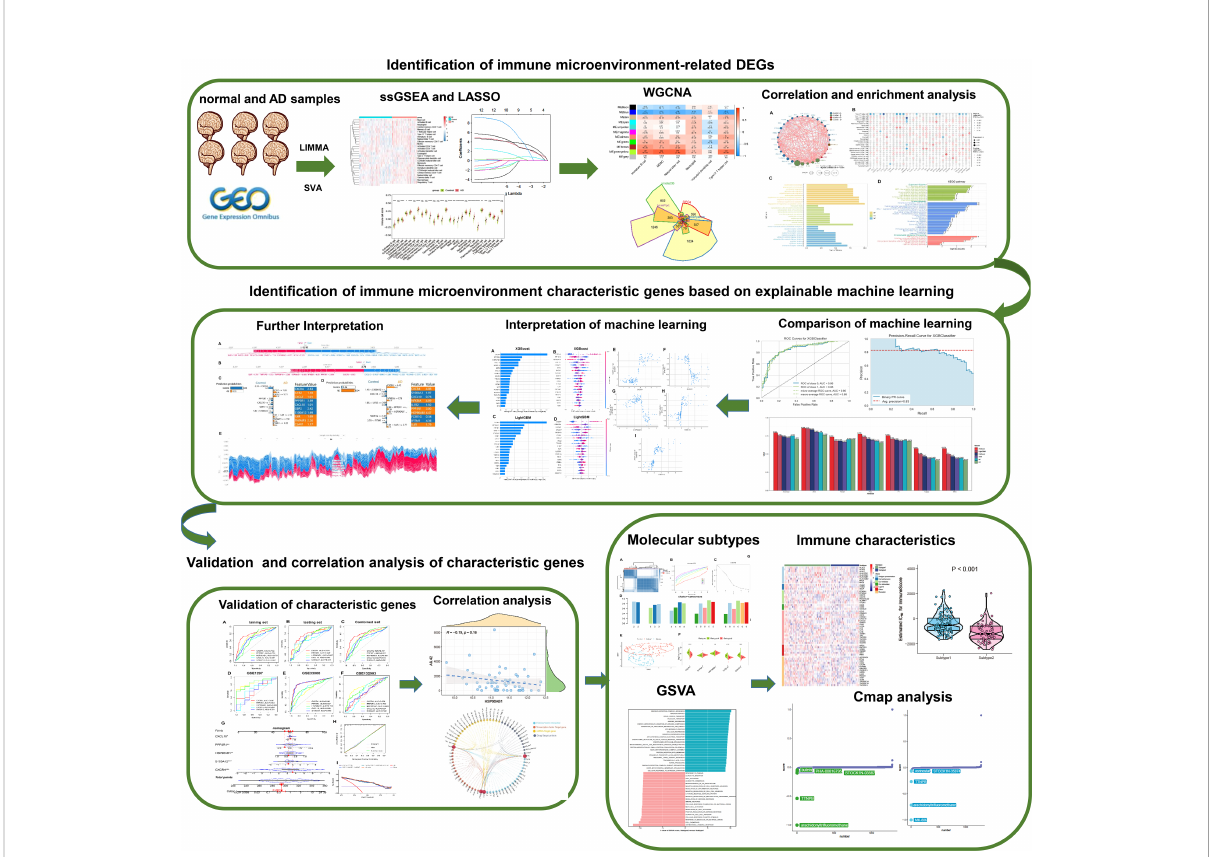
FIGURE 1 The study fl ow chart. Step1: Identi fi cation of immune microenvironment-related DEGs. 1) AD-related immune cells shared by the integrated and external validation datasets were found using the LASSO and ssGSEA algorithms. 2) The immune microenvironment-related DEGs were identi fi ed using the WGCNA method and immune-related internet resources. 3) Analysis of DEGs connected to the immunological microenvironment in terms of correlation and functional enrichment. Step2: Identi fi cation of immune microenvironment characteristic